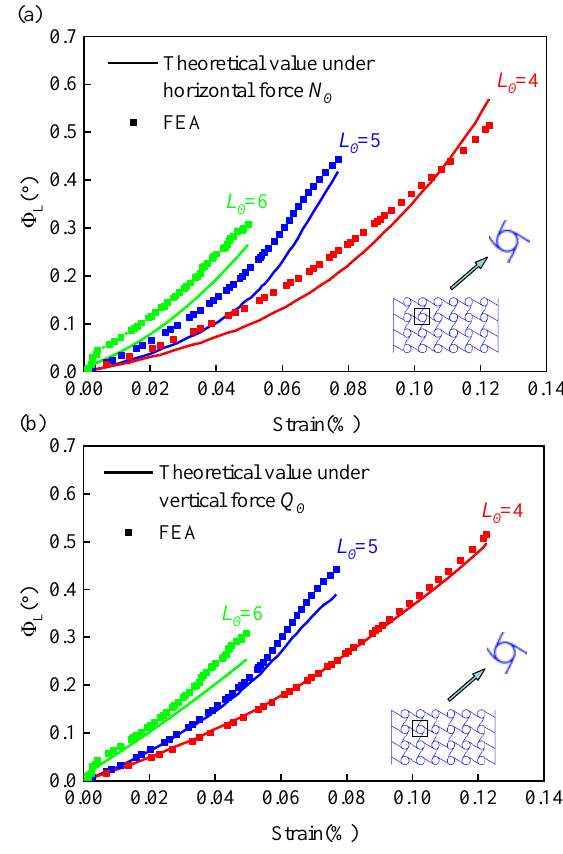
Figure 4. Curves of the rotation angle and strain at node ‘A’ for different ligament lengths. ( a ) Rotation angle-strain relationship curve under horizontal force; ( b ) Rotation angle-strain relationship curve under vertical force.